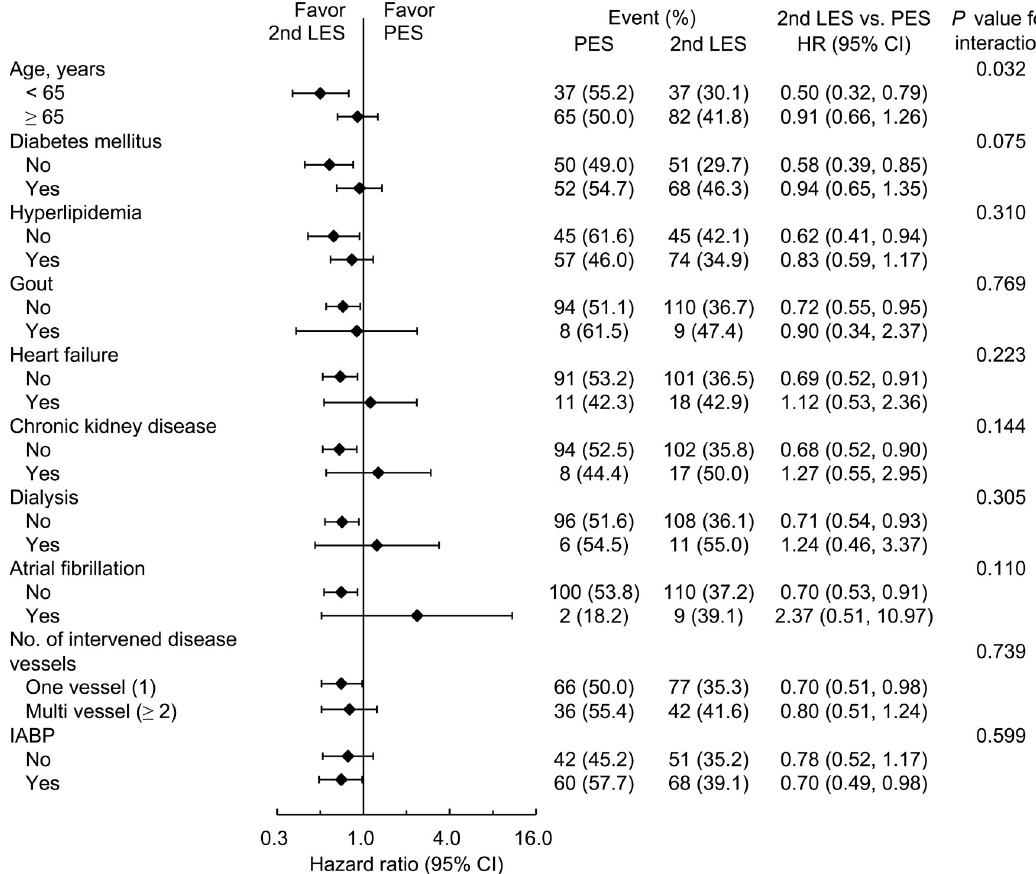
Fig 2. Pre-specified subgroup analysis for primary composite